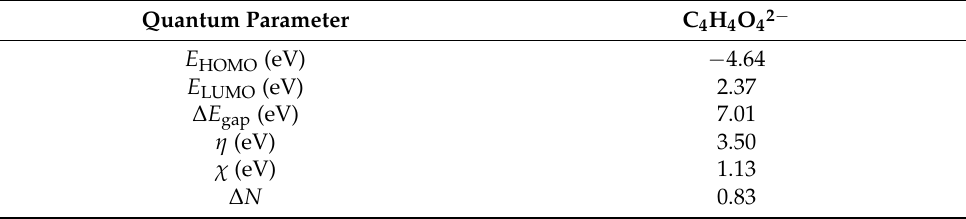
Table 6. Calculated quantum chemical parameters for succinate ion (C 4 H 4 O 42 − ).